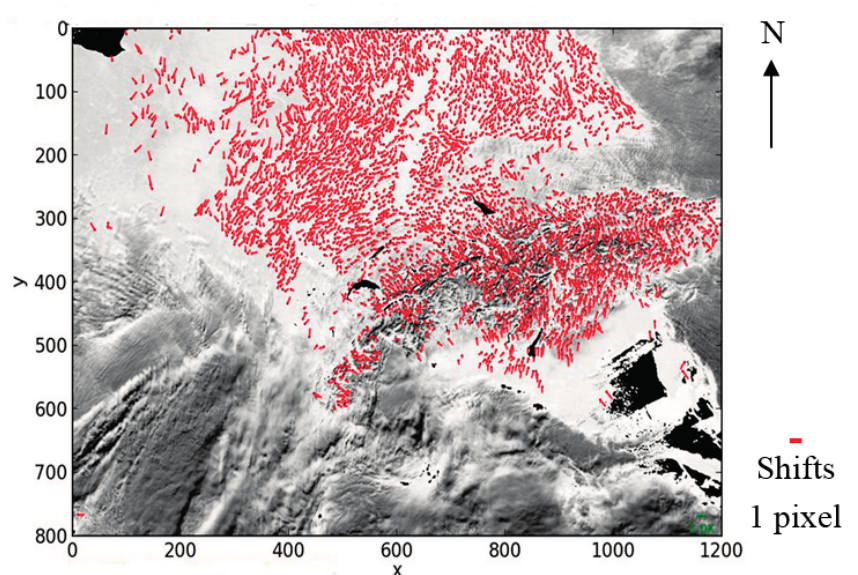
Figure 9. Image space shifts obtained from matching of NOAA-17 and Metop-A images acquired on 26 December 2008. The axes denote the image coordinates.